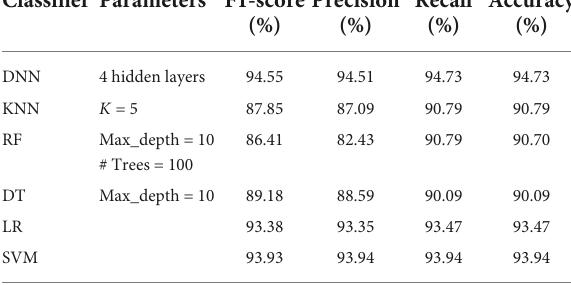
TABLE 7 Performance analysis of classifiers on DS3 dataset.